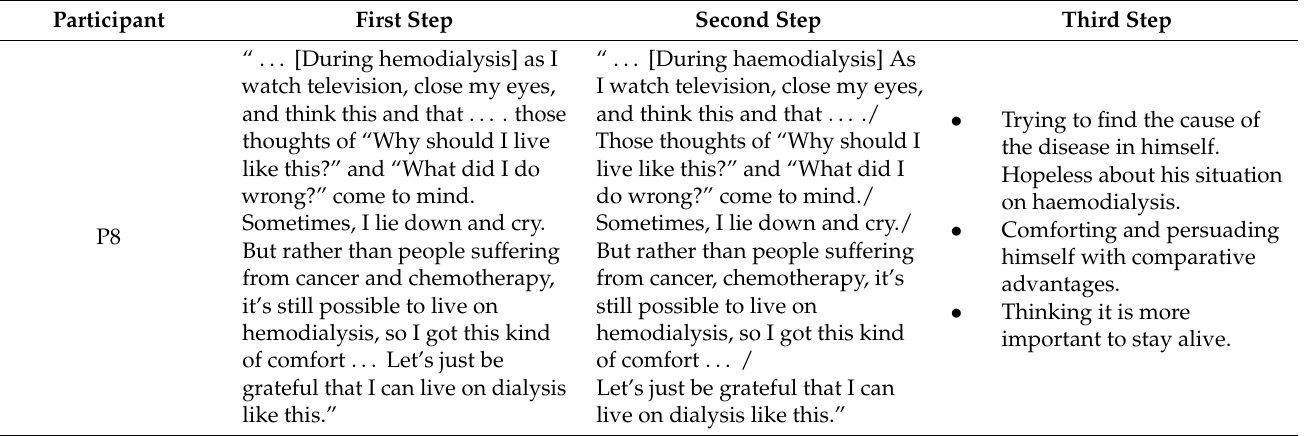
Table 2. Example of the step-wise qualitative analysis process.